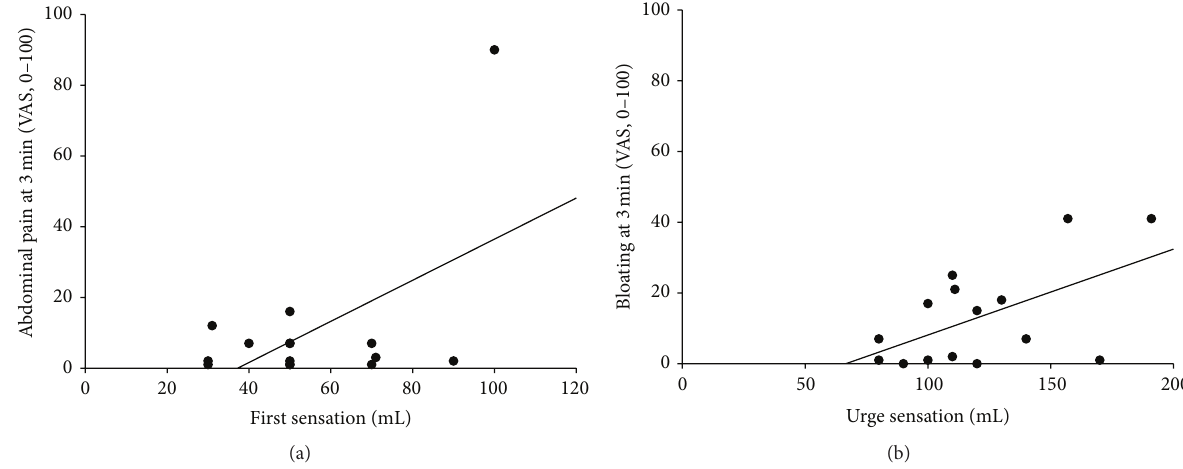
Figure 2: Association between abdominal symptoms and anorectal manometry after rectal tube treatment. Abdominal pain at 3 minutes correlates positively with first sensation ( 𝑟 = 0.53 , 𝑃 = 0.04 ) (a); bloating at 3 min correlates positively with urge sensation ( 𝑟 = 0.55 , 𝑃 = 0.03 ) (b). Values are expressed as mean ±